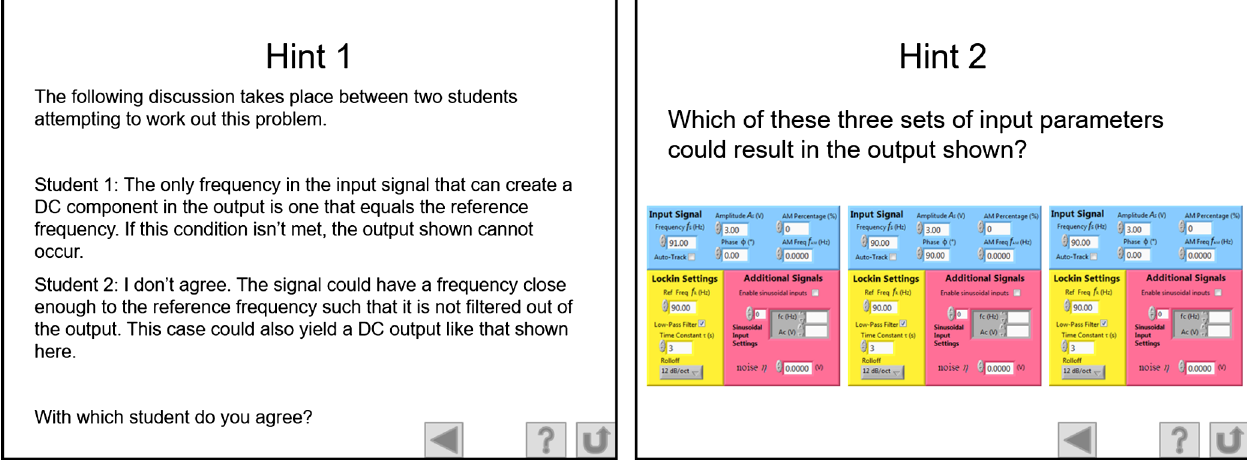
FIG. 4. Examples of two types of hint commonly provided to scaffold student